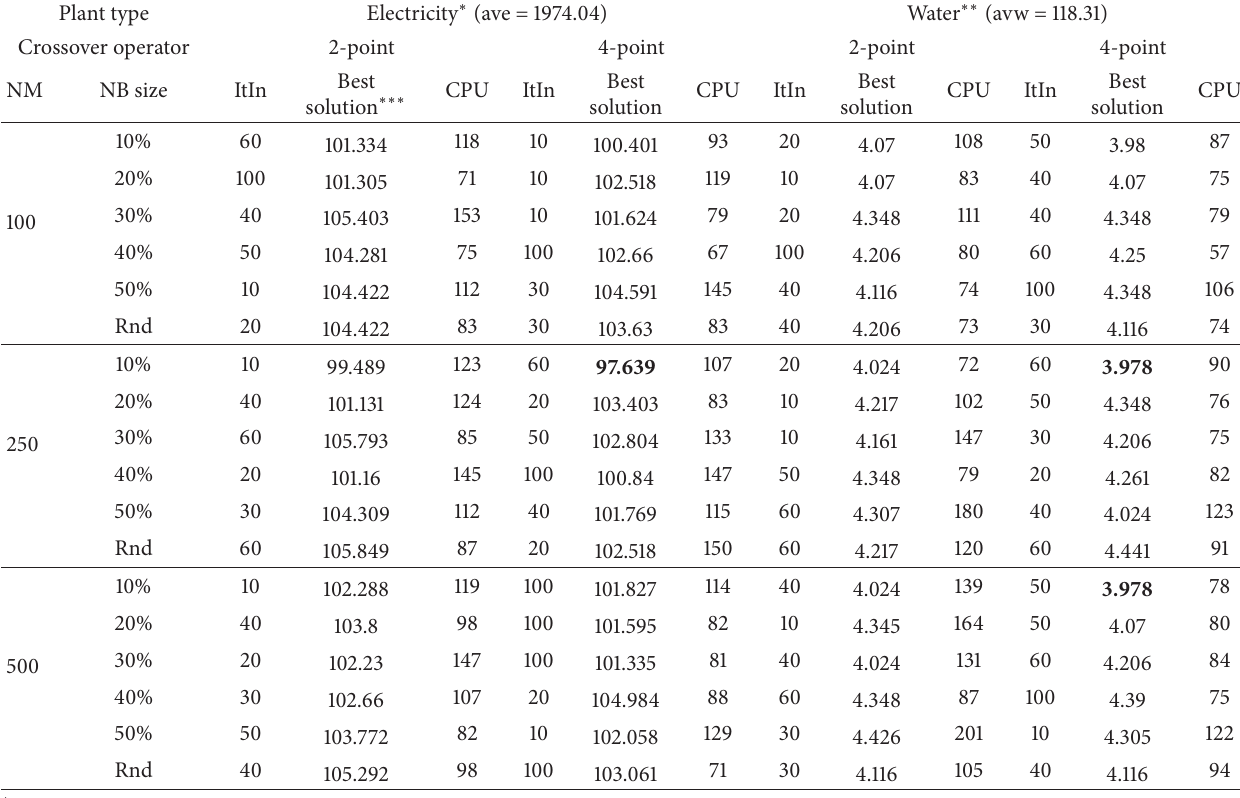
Table 1: Summary results of the computational experiments.